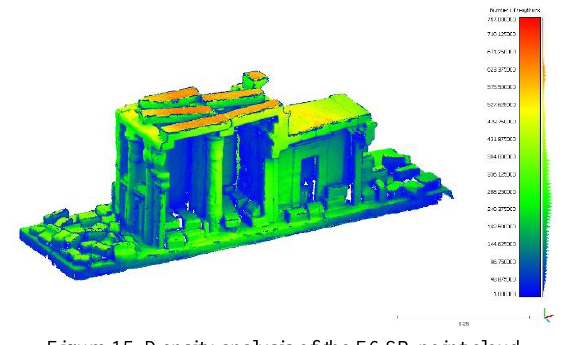
Figure 15. Density analysis of the F6 SR point cloud